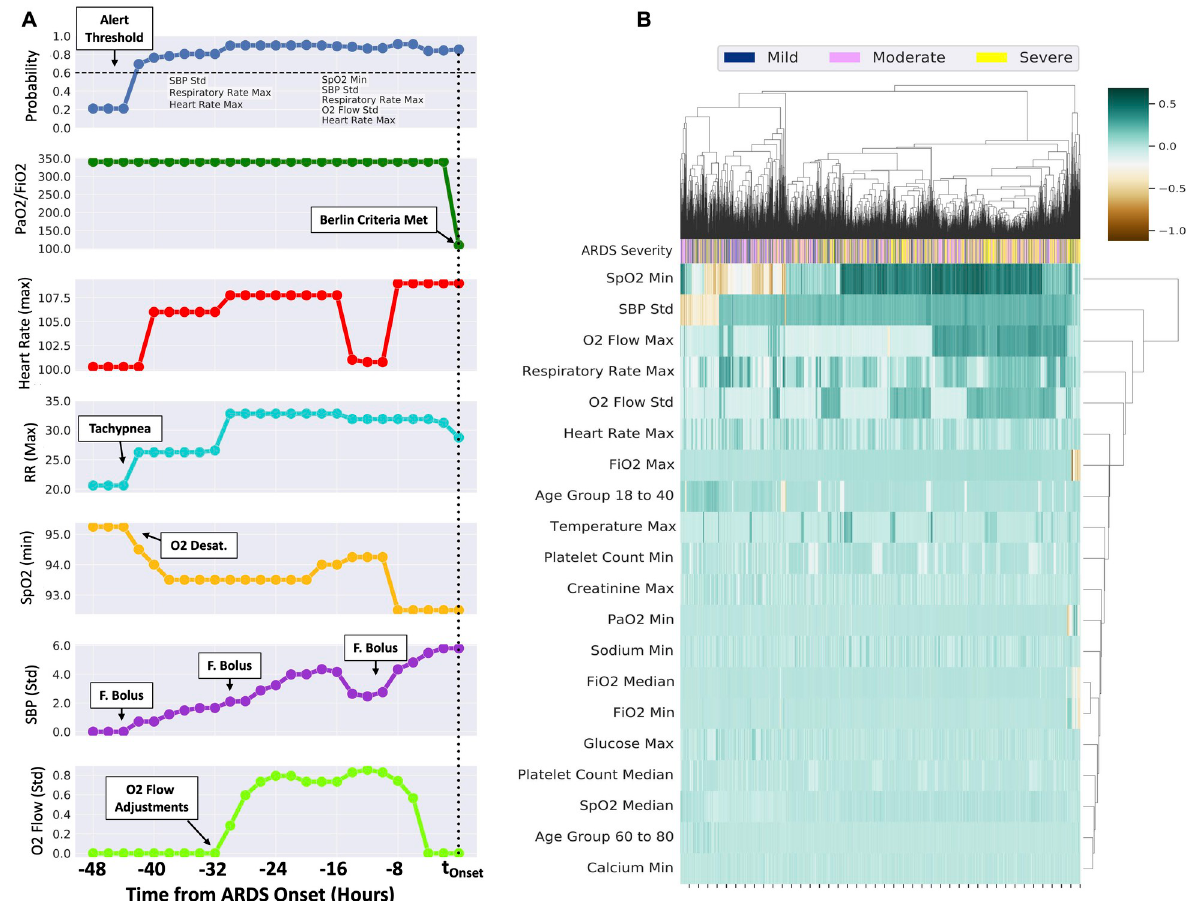
Fig 3. A. Example patient who develops an increased risk for ARDS over 48 hours before meeting the Berlin Criteria, the top panel illustrates probability and the second panel illustrates the PaO 2 /FiO 2 ratio, while the third through last panels illustrate the top features identified in the model. Note that P/F ratio was not included in the model input, and illustrated for demonstration purposes. B. Illustrates the cluster heatmap of 20 most significant features derived by aggregating SHAP values for each prediction at six hours prior to t onset . Patients are enumerated column-wise, and clustered on disease severity, namely, mild, moderate and severe. Two groups are observed, the left consisting of the mild and moderate groups, while the right consists more of the severe (yellow) group.